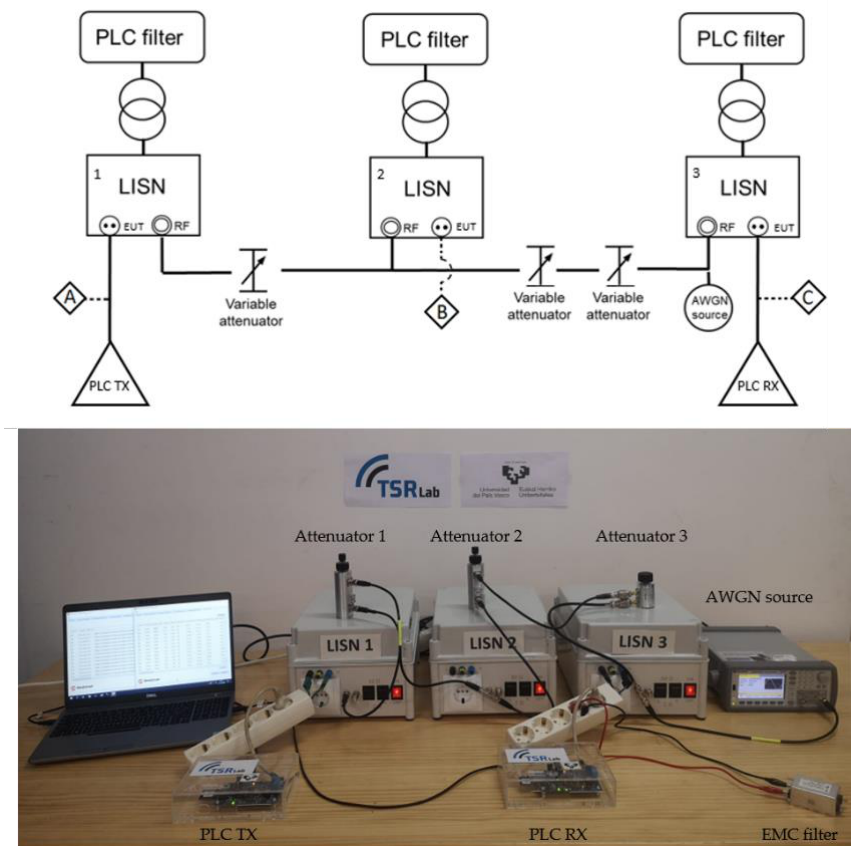
Figure 4. Measurement setup. EMC filters are connected at either points A, B or C. For the measurement of channel frequency response, the signal is injected at point A and measured at point C.